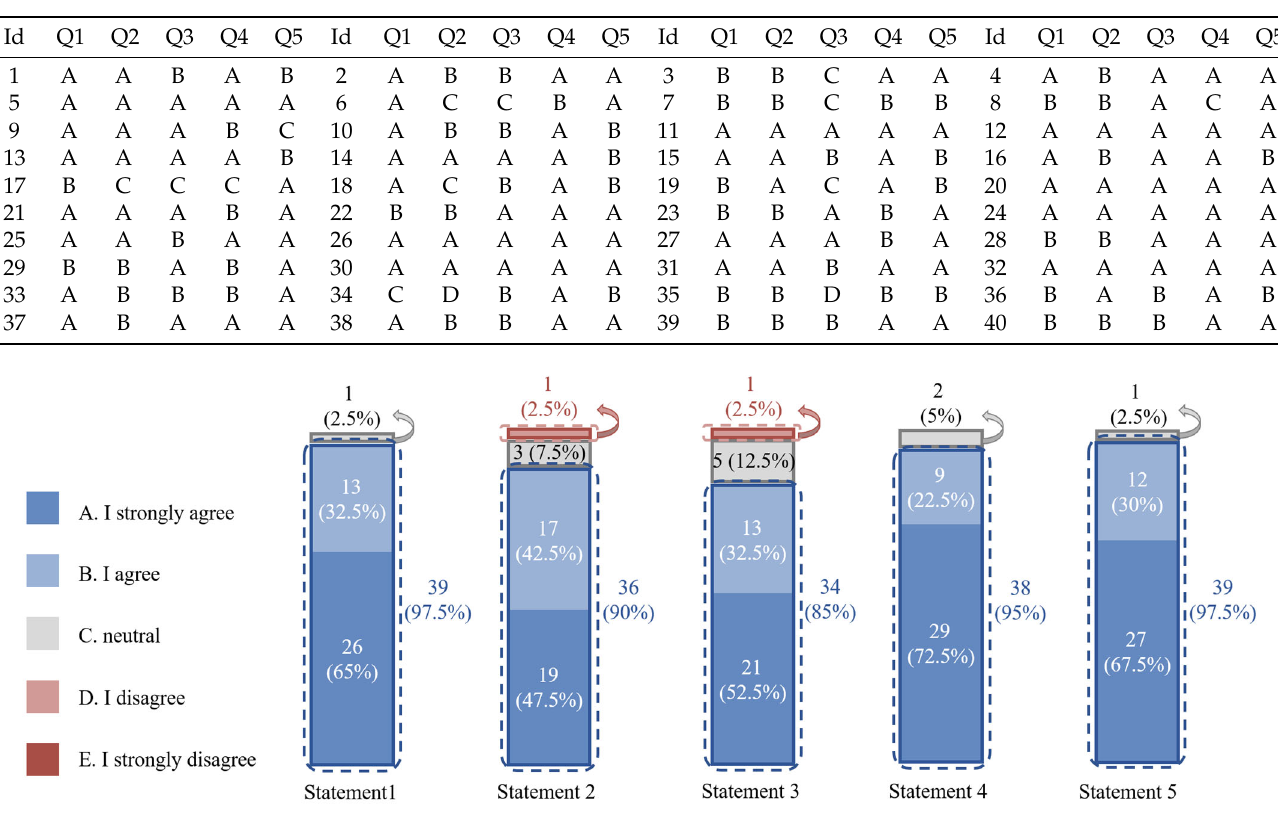
Table 3. Questionnaire answers from all respondents.